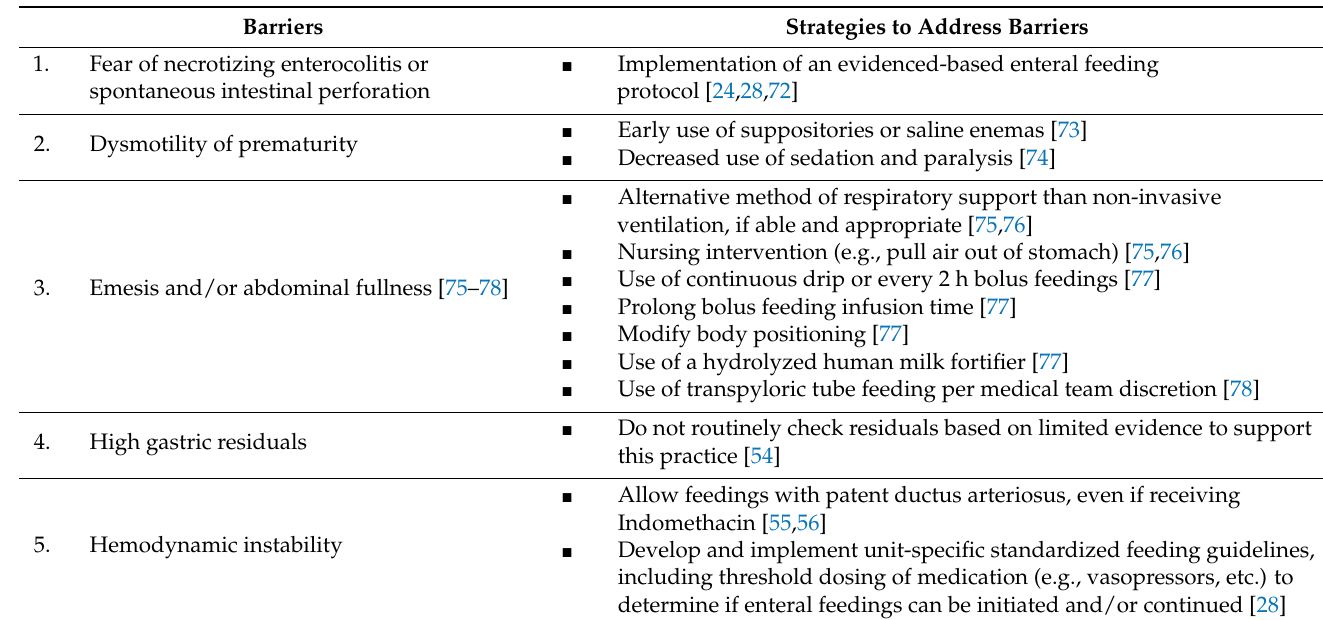
Table 2. Barriers and strategies to initiating and advancing early life enteral feeding in preterm